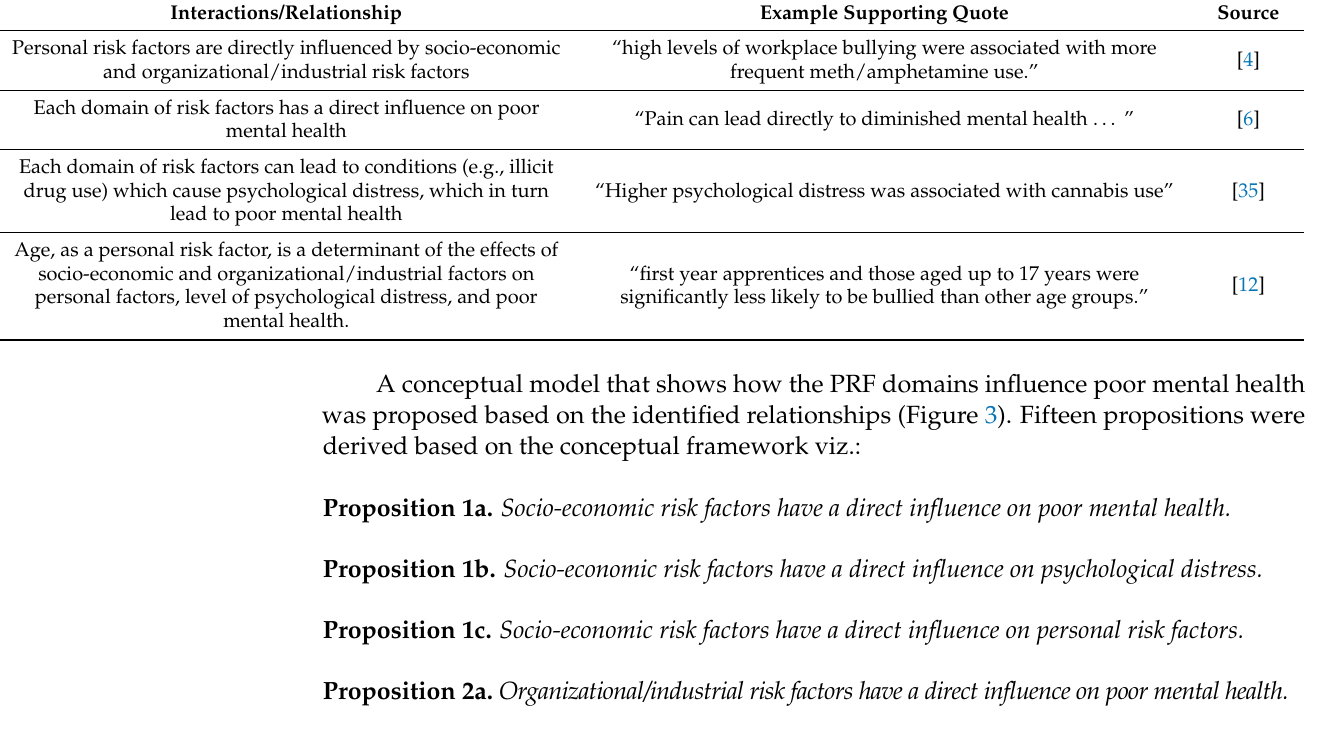
Table 5. Relationships between psychosocial risk factors and their influence on poor mental health. Interactions/Relationship Example Supporting Quote